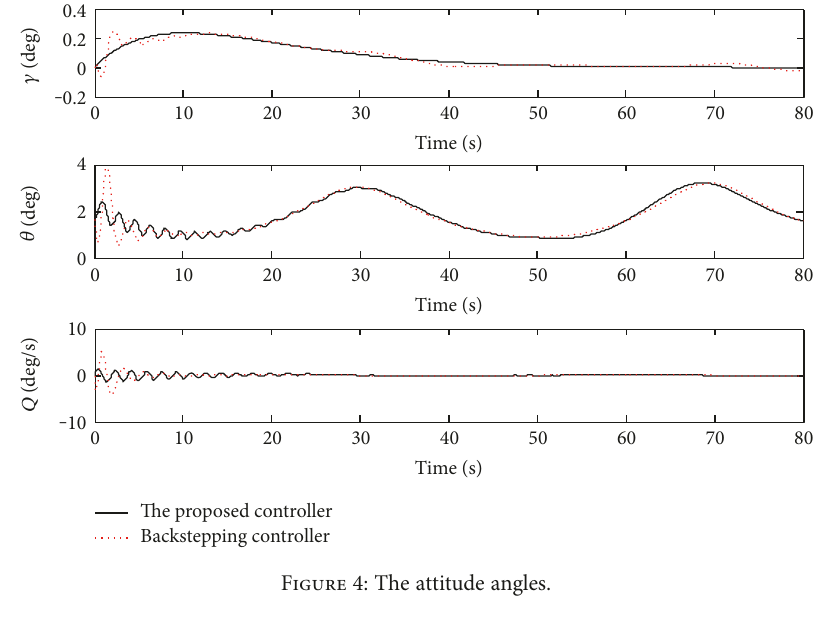
Figure 4: The attitude angles.